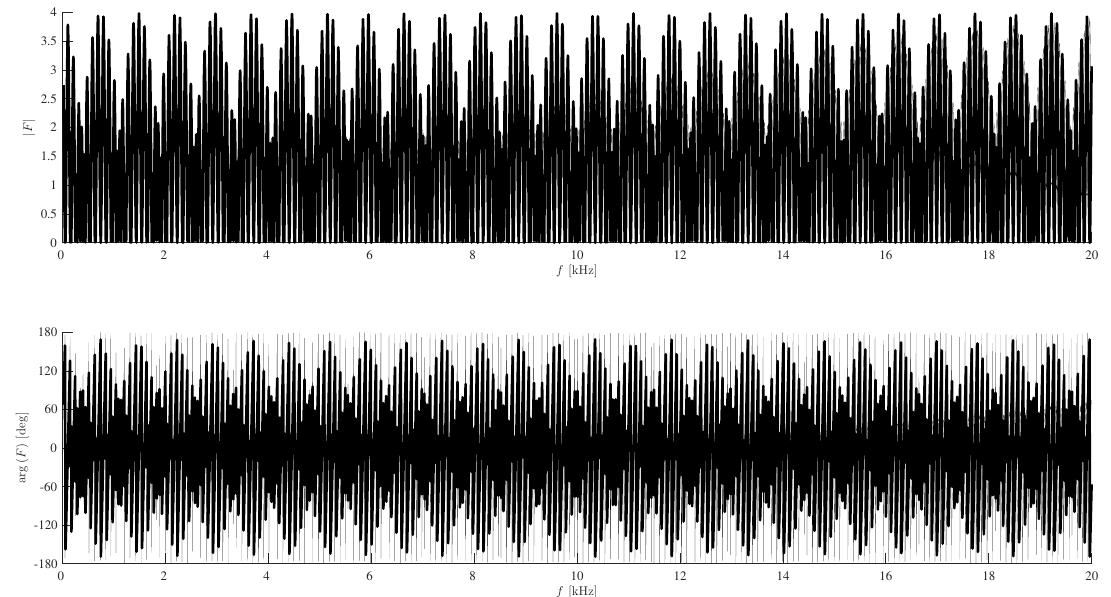
Figure A6: The same as Figure A3 for high source direction, β = 60 °, above the diagonal.